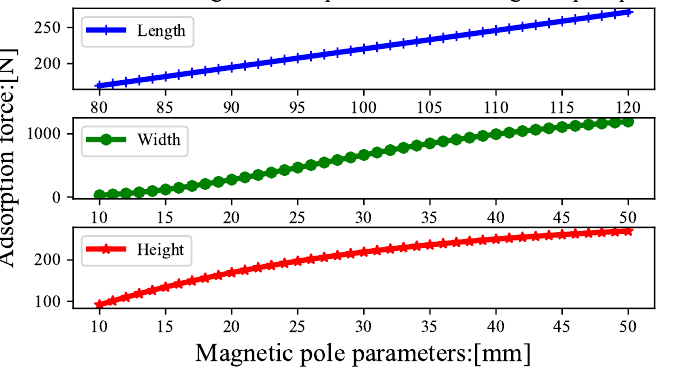
Figure 17. Variation curve of the magnetic adsorption force with magnetic pole